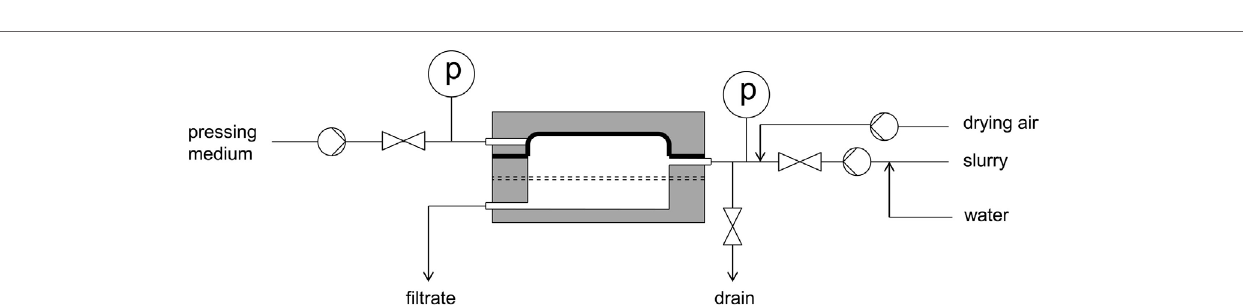
FigUre 3 | Test unit setup for pressure filtration .